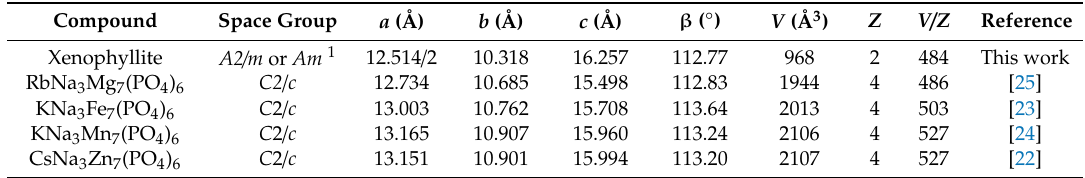
Table 6. Comparison of a monoclinic subcell of xenophyllite with the unit cells of